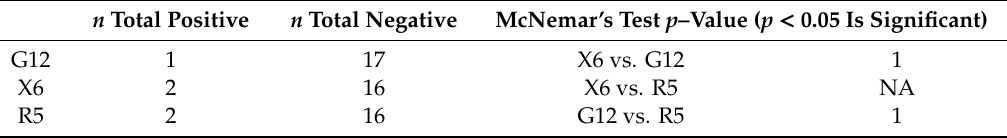
Table 6. Gluten quantification in “snack” group ( n = 18).